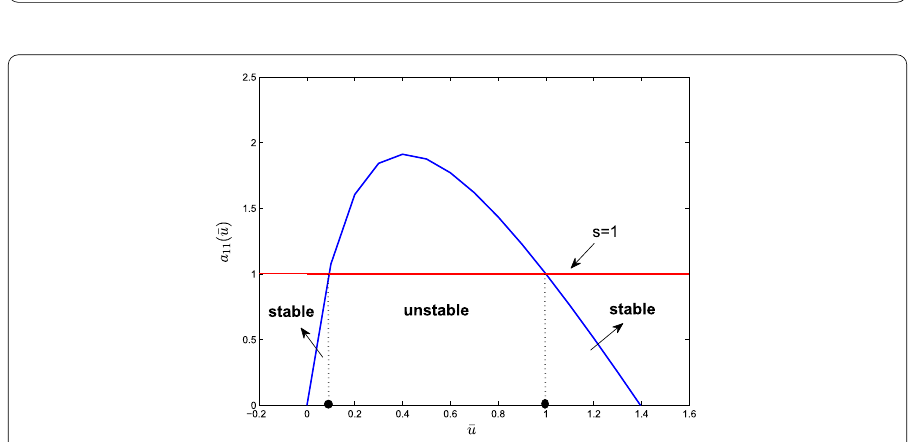
Figure 3 The first line shows the stability of system (1) changes with the values of s when χ > χ 0 , Hopf bifurcation occurs as s decreases through the point 1.911. The second line shows that the prey populations are unstable for χ < χ 0 , and Hopf bifurcation occurs for χ > χ 0